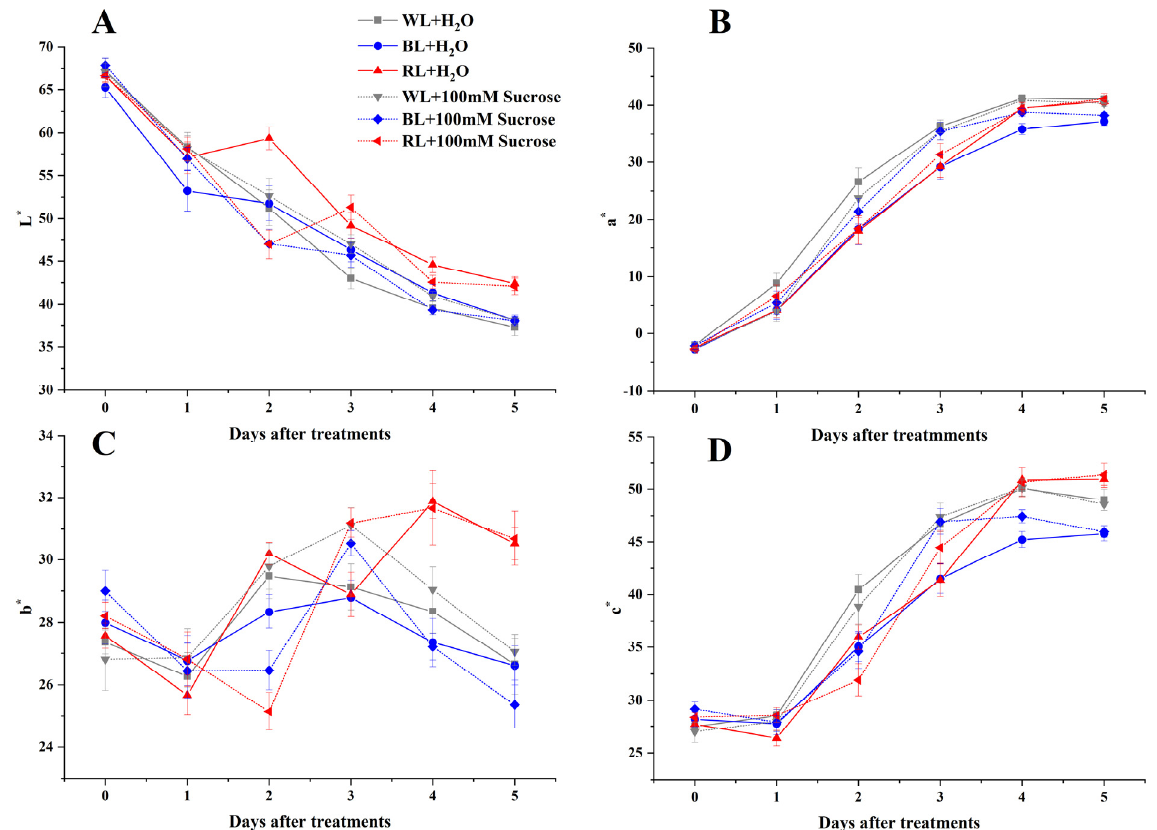
Figure 1. Effect of light quality and sucrose on skin color parameters of L* value ( A ), a* value ( B ), b* value ( C ), and C* value ( D ). Data represent the means ± standard error ( n = 3).